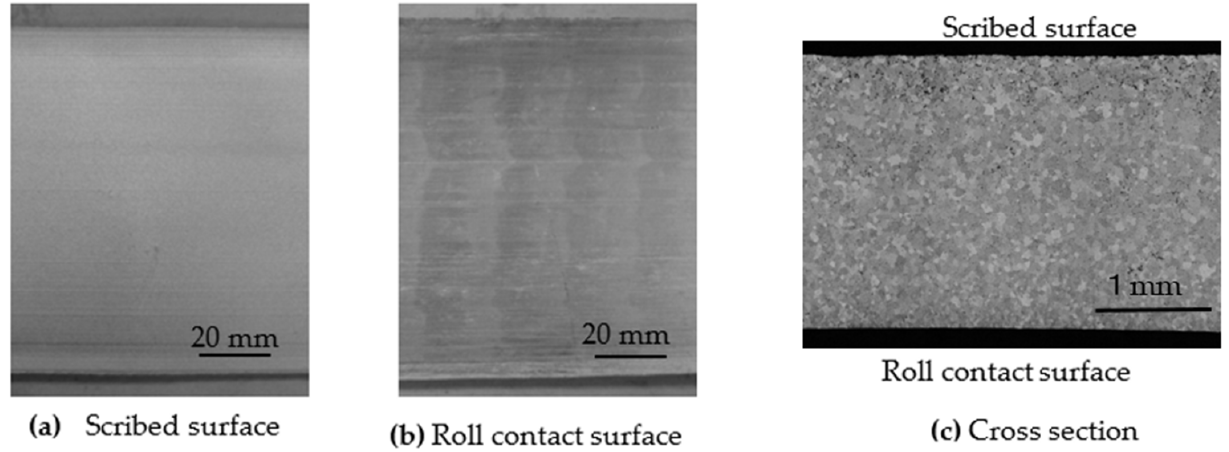
Figure 22. Surfaces, cross section and thickness distribution of as-cast 5182 strip using a single-roll caster equipped with a scraper. Aluminum alloy: 5182, Roll diameter: 300 mm, Roll width: 100 mm, Roll speed: 40 m/min, Solidification length: 200 mm, Scraper load: 0.2 N/mm.